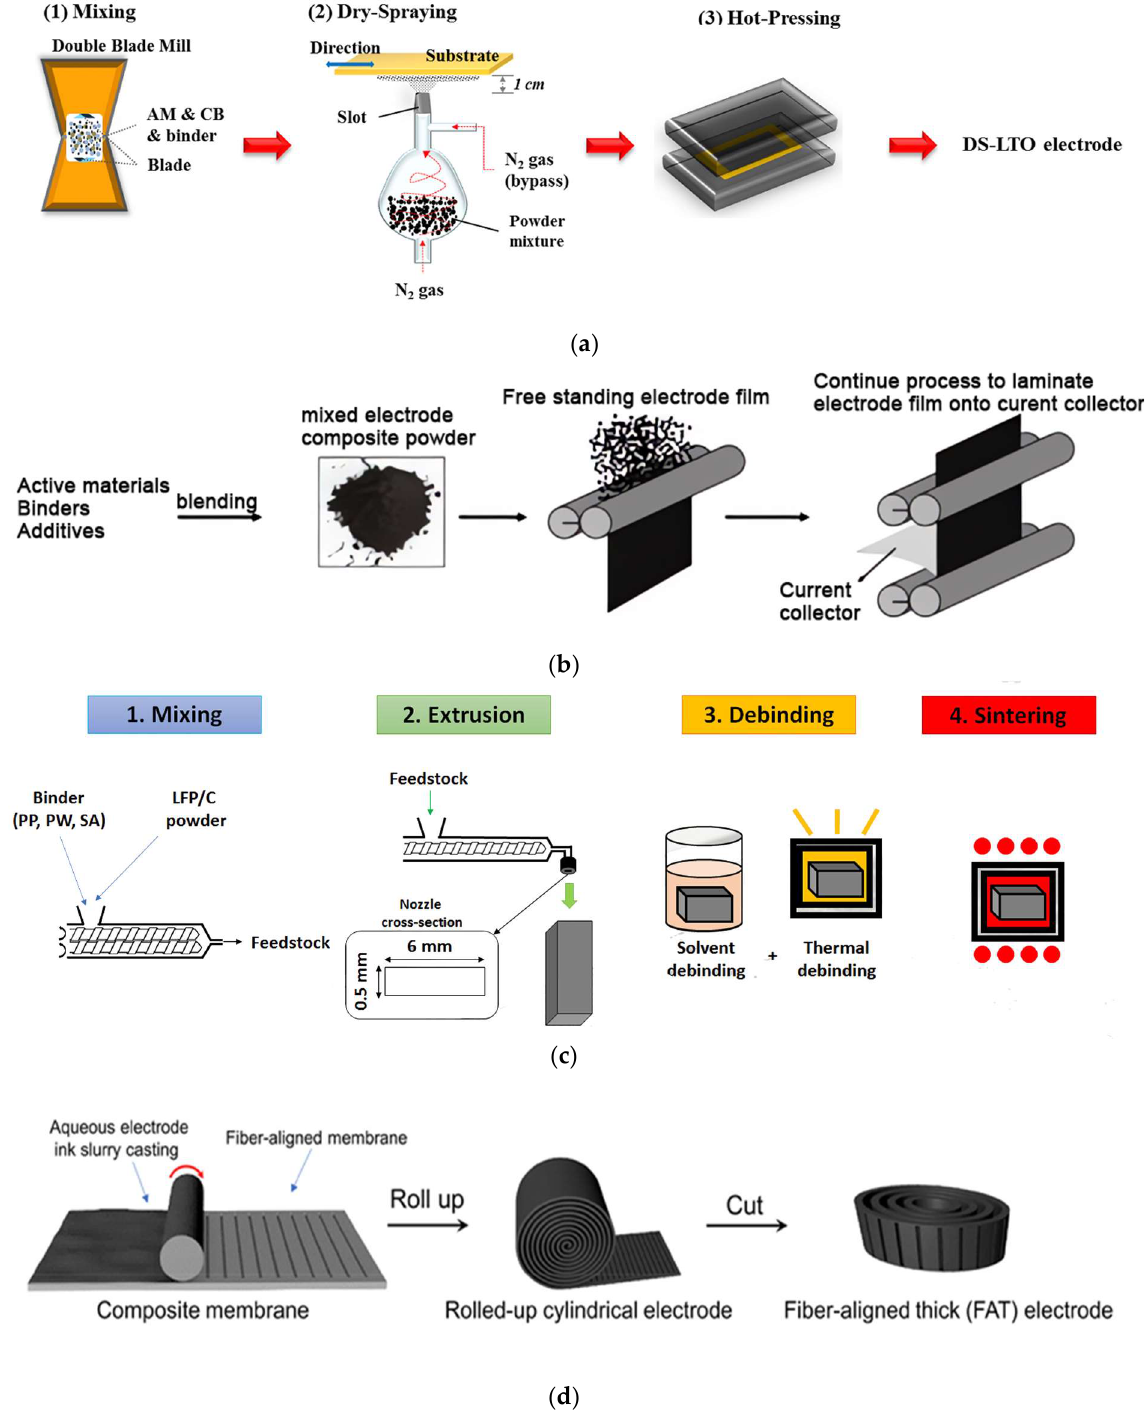
Figure 6. ( a ) A schematic of the dry spraying process [59]. ( b ) A schematic of the dry coating process. ( c ) Schematic illustrations of powder extrusion moulding [67]. ( d ) Schematic fabrication of fiber-aligned thick electrode [9].